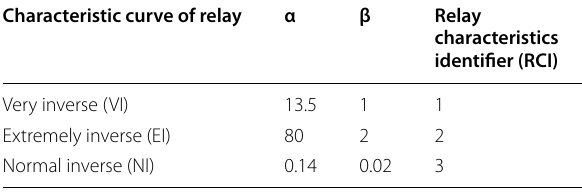
Table 1 Overcurrent relay characteristics coefficient, according to IEC-60255 std Characteristic curve of relay Relay